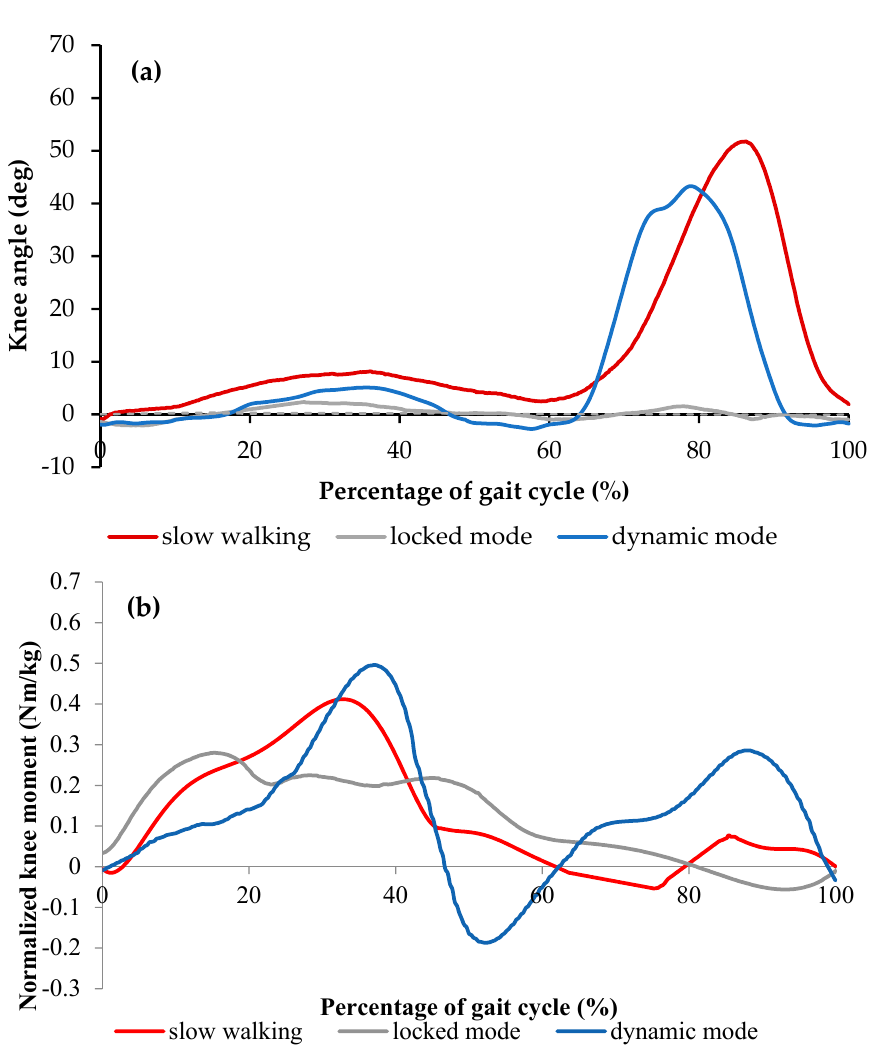
Figure 16. ( a ) Knee angle and ( b ) Knee moment over the entire gait cycle with one standard deviation in the three walking conditions [46].